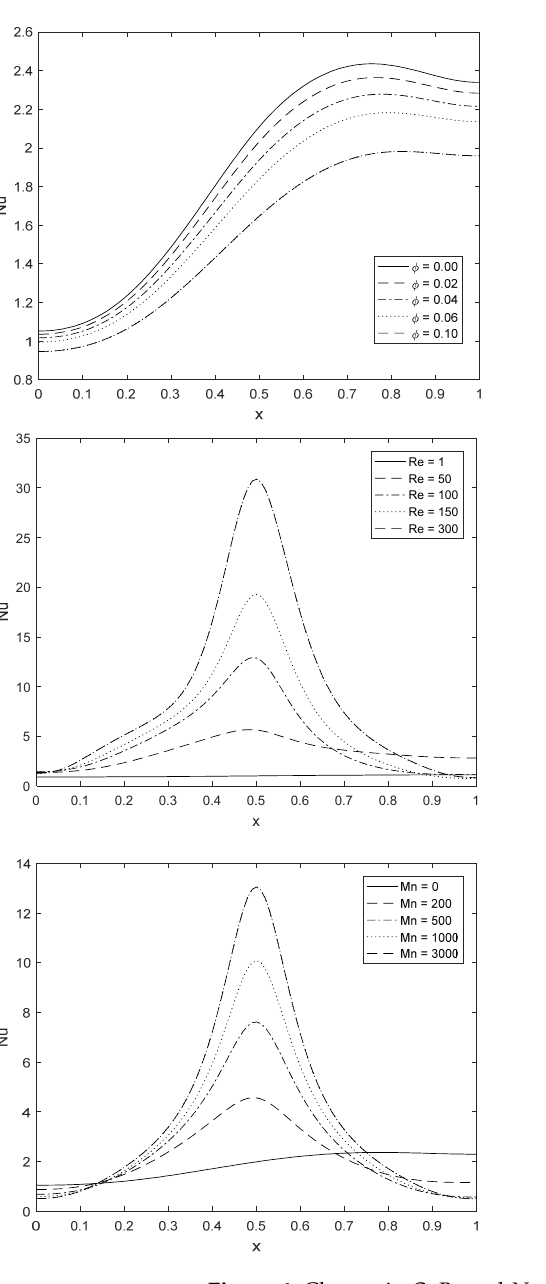
Figure 6. Change in C f R e and N u at the dipole location along the lower wall . At the beginning, when there is no dipole located near the cavity, the behavior of the streamlines is quite smooth with a clockwise vortex near the upper wall. As the upper plate is moving, a high-velocity gradient can be seen along the upper wall. An anti- clockwise lowering vortex seems to appear near the dipole from right side with the im- pact of magnetic field. As the magnetic fields strengthen, this lower vortex starts grow- ing, and another tiny vortex appears from the primary vortex. Consequently, there are three vortices in total at 3000 Mn = , and the two secondary vortices are originating near the dipole location. Mn = 0 Mn = 100